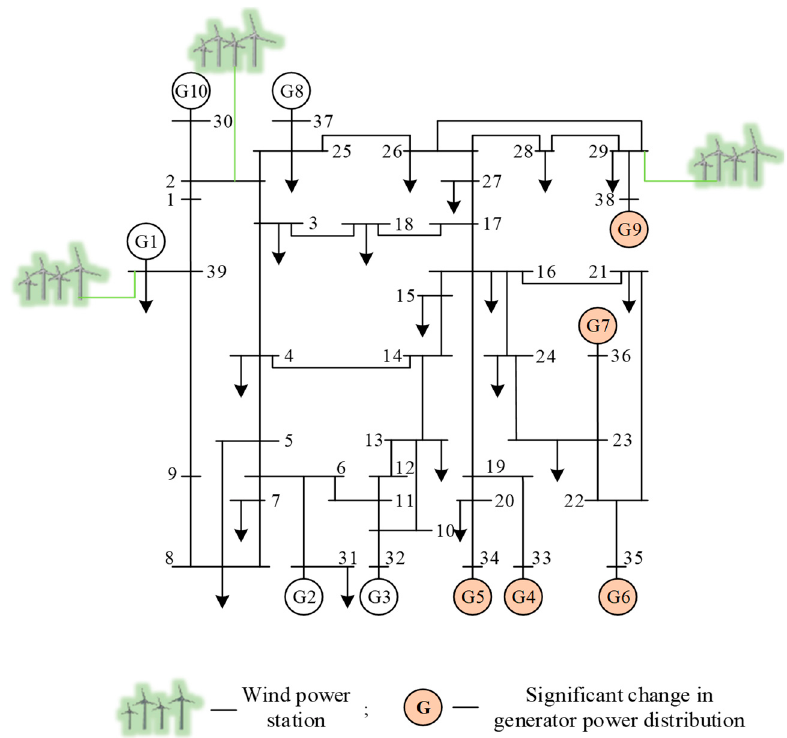
Figure 7. Topology of scenario 2 of the modified New England 39-bus system.